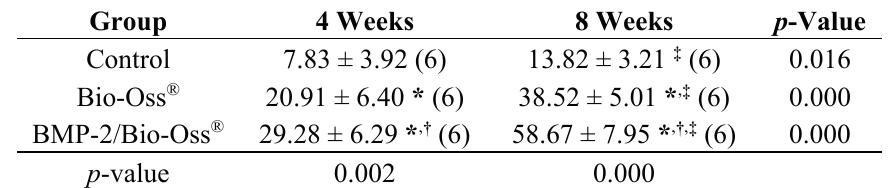
Table 3. Percentages of the defect closure (means ± SD (number of specimens)).